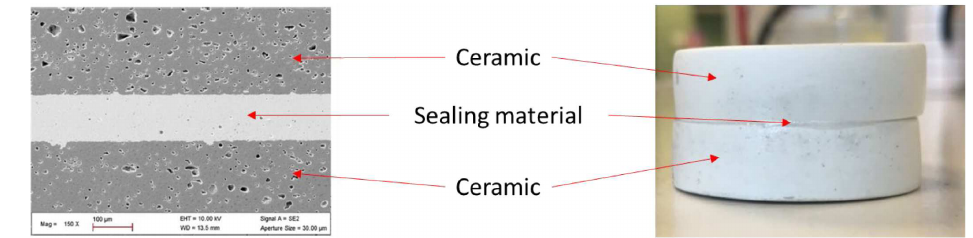
Fig. 1. SEM micrograph of the interfaces between the seal and the ceramic parts (left) and photo of a sealing test (right). (Courtesy of I. Cornu and F. Rossignol, IRCER, Universit´e de